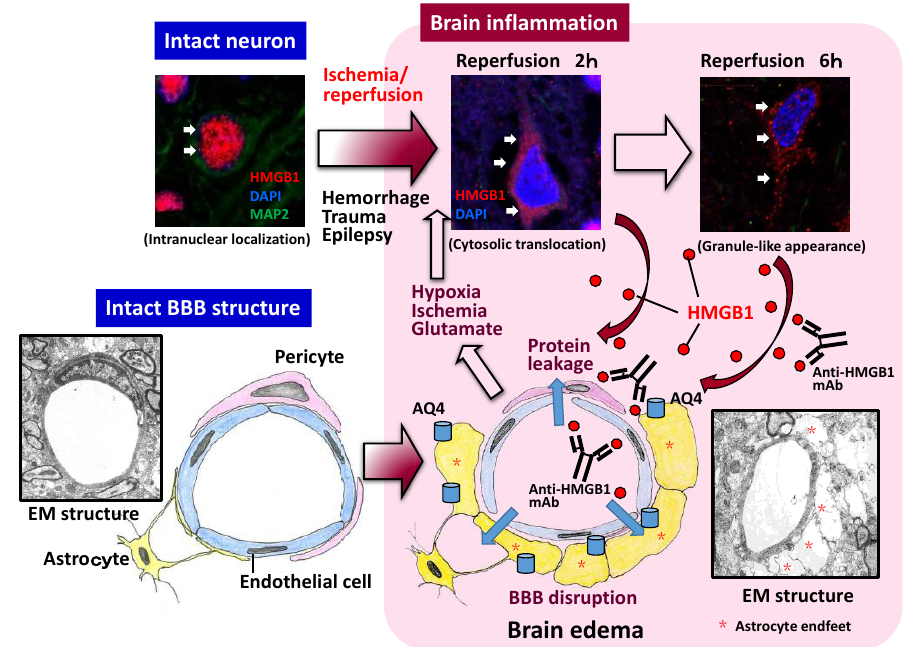
Figure 2. HMGB1 translocation and release after insults and its involvement in BBB disruption. In the upper three squares, typical HMGB1 translocation and release from the nucleus to extracellular space are shown after 2 h of occlusion/reperfusion of the middle cerebral artery. The released HMGB1 then affects the vascular endothelial cells and pericytes, leading to protein leakage and brain edema formation. BBB disruption further promotes HMGB1 translocation. There might be a positive feedback loop between BBB disruption and HMGB1 translocation. The existence of such a loop may be a reason why anti-HMGB1 therapy inhibited BBB disruption and HMGB1 translocation simultaneously.